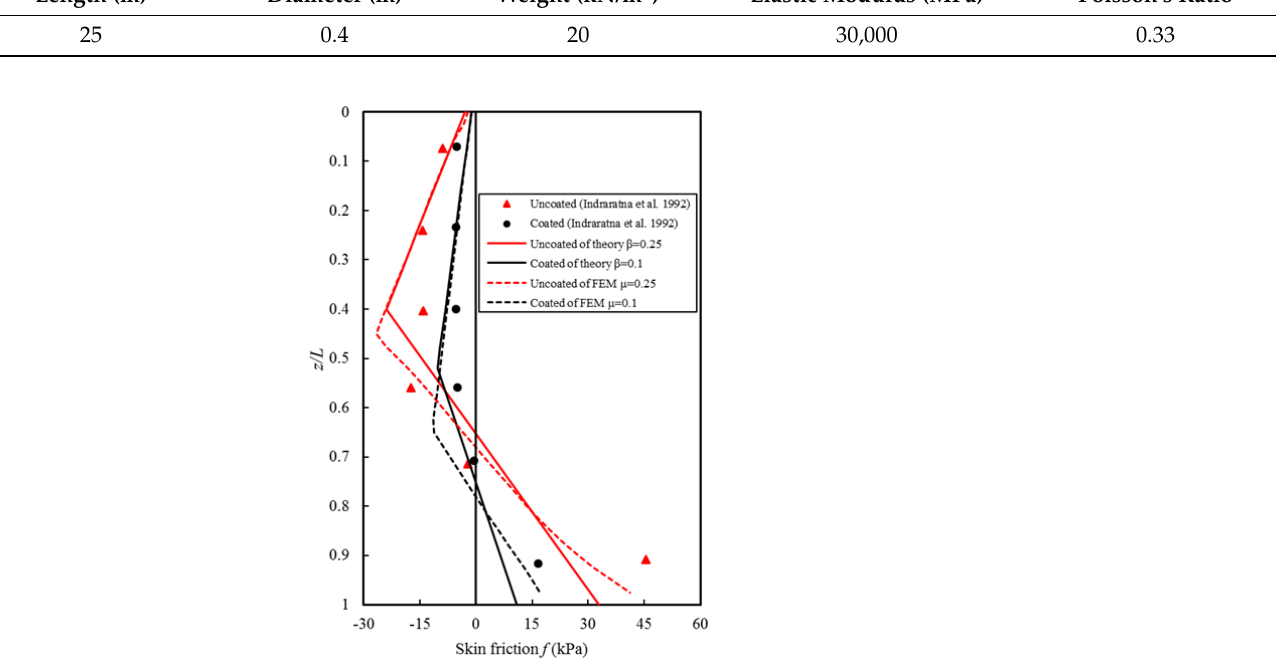
Figure 4. Comparison among ESM, FEM and measured data. Table 2. The parameters of consolidating layer.